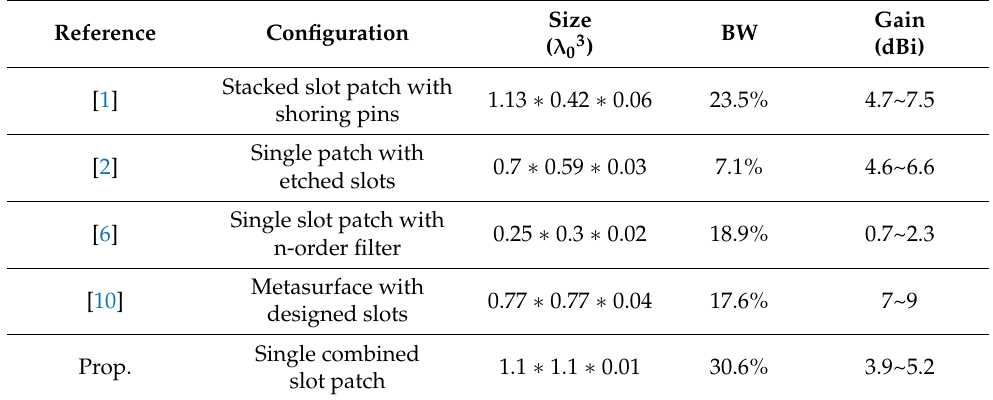
Table 1. Comparisons of filtering